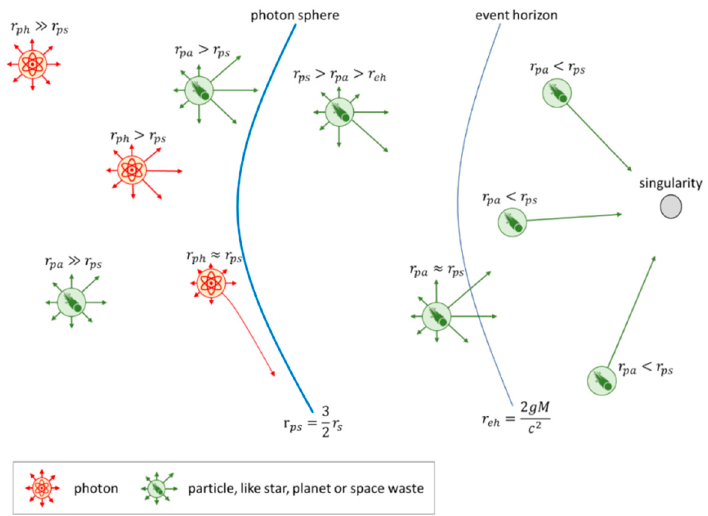
Figure 11. Impact of photon sphere and event horizon on moving particles and photons.